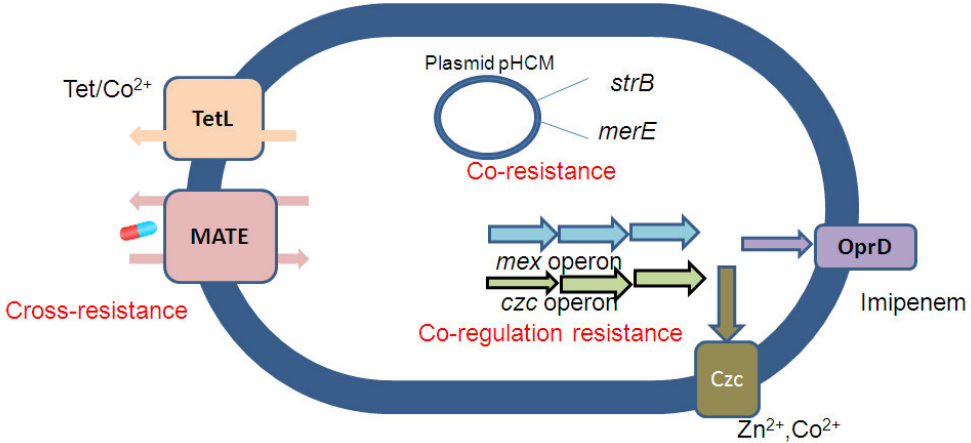
Figure 2. Examples of molecular mechanisms that underline metal and antibiotic co-selection (in- spired from [10]). Table 1. Example of cross-resistance to both antibiotics and metals [10,27].